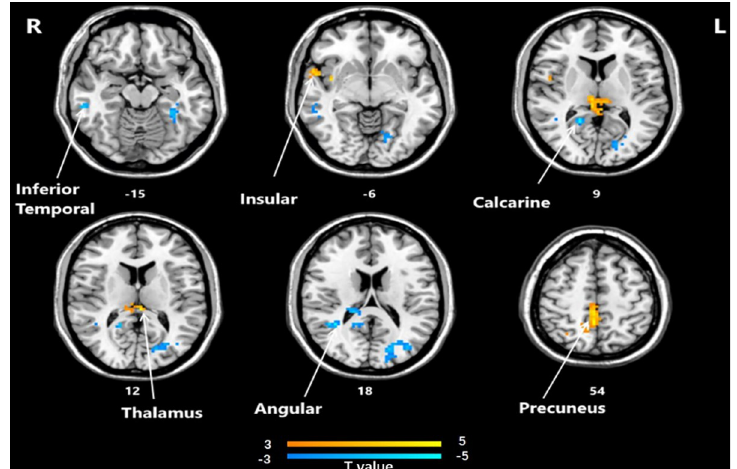
Fig 2. Brain regions that showed significant alterations in fALFF before and after HD-tDCS. (P < 0.05, AlphaSim corrected). The yellow color denotes post-HD-tDCS > pre-HD-tDCS in the fALFF values and the blue color denotes post-HD-tDCS < pre-HD-tDCS. The T-value bars are shown at the bottom. The brain regions with significant increases in fALFF include Temporal Inf R, Fusiform L, Occipital Sup L, Calcarine R, Angular R. However, Insula R, Precuneus R, Thalamus L, and Parietal Sup R decreased significantly. fALFF, fractional amplitude of low-frequency fluctuation; HD-tDCS, high-definition transcranial direct current stimulation.